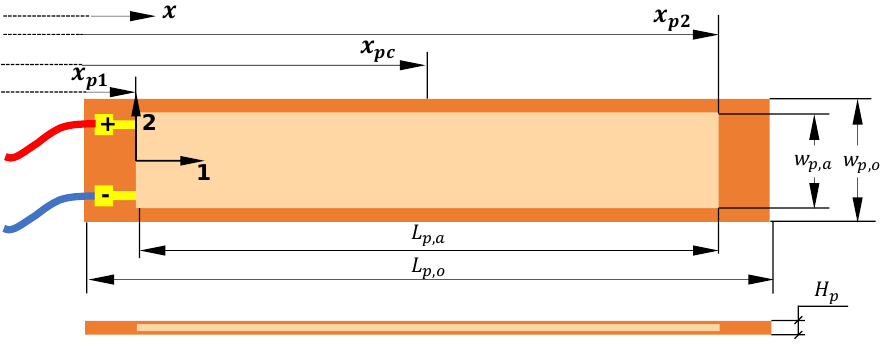
Figure 7. Scheme of M8514 — P2 patch (main dimensions and the local reference frame are depicted).